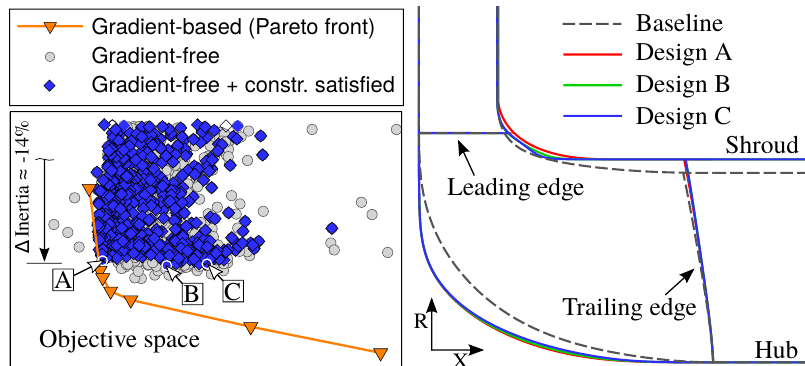
Figure 10. Comparison of meridional shapes of three designs (A, B, C) with respect to the baseline geometry.